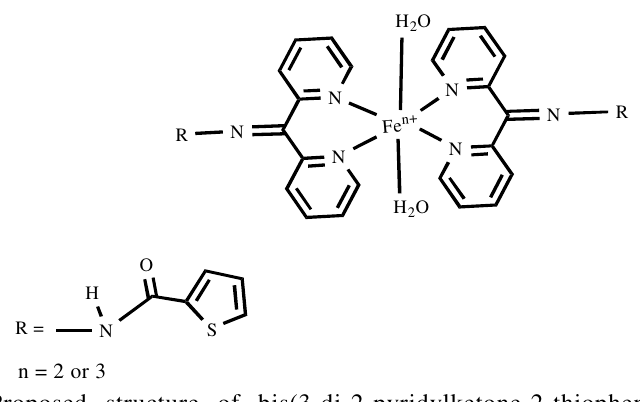
Figure 2. Proposed structure of bis(3-di-2-pyridylketone-2-thiophenylhydrazone) iron(II)/(III) complexes